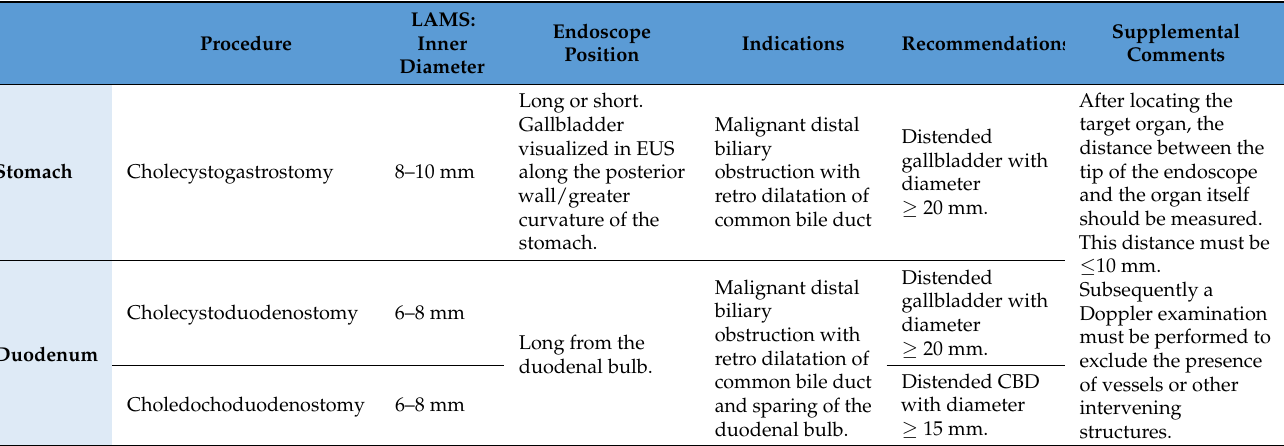
Table 1. Summary table based on the site of